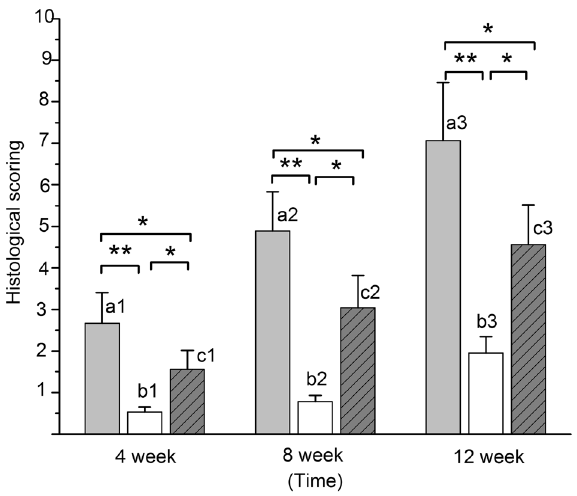
Fig. 8 Histograms of histological scores between each group at 4, 8, and 12 weeks. The letters a1, b1, and c1 represent Groups A, B and C at 4 weeks, respectively. In the same way, a2, b2, and c2, and a3, b3, and c3 represent Groups A, B, and C at 8 and 12 weeks, respectively. Values are expressed as the mean ± S.D.; n = 12 per group. “ * ” and “ ** ” represent signi fi cant differences between the different groups at the same time (* P < 0.05 and ** P <